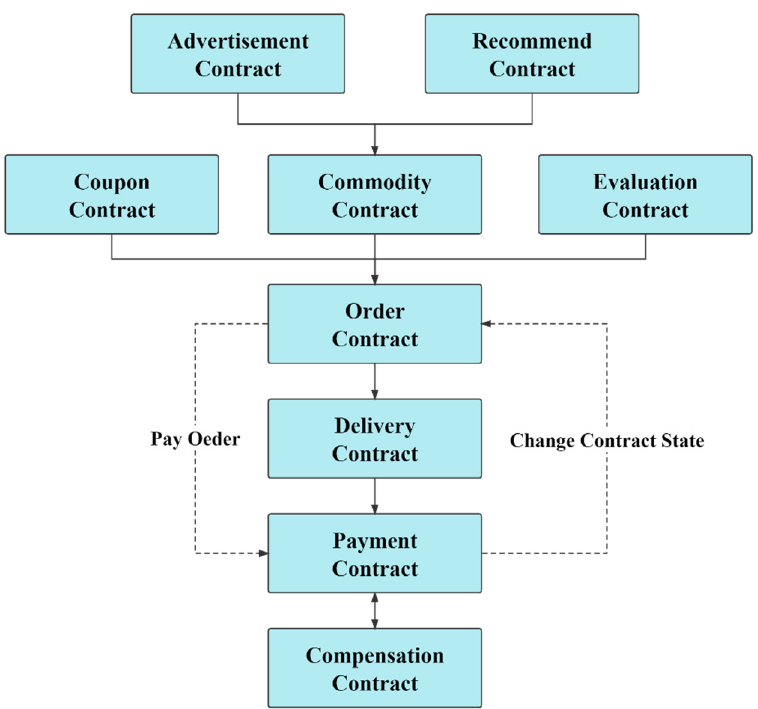
Figure 9. Smart contracts in the blockchain network rely on each other to form a complete business process.